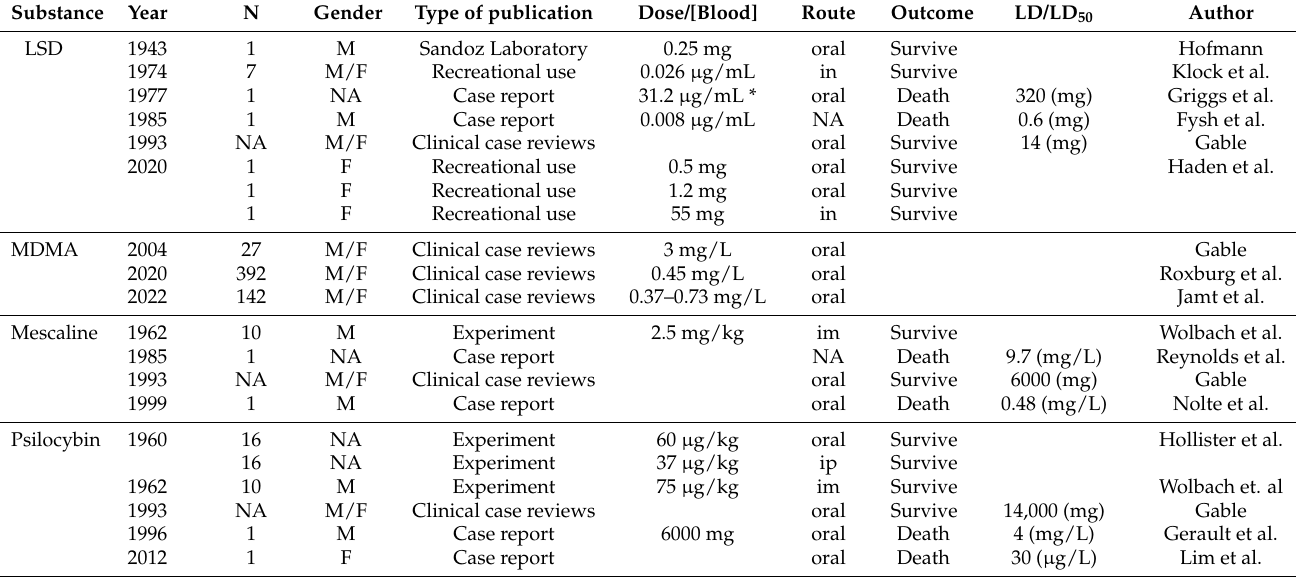
Table 2. Description of clinical reports related to high/lethal doses of psychedelics in